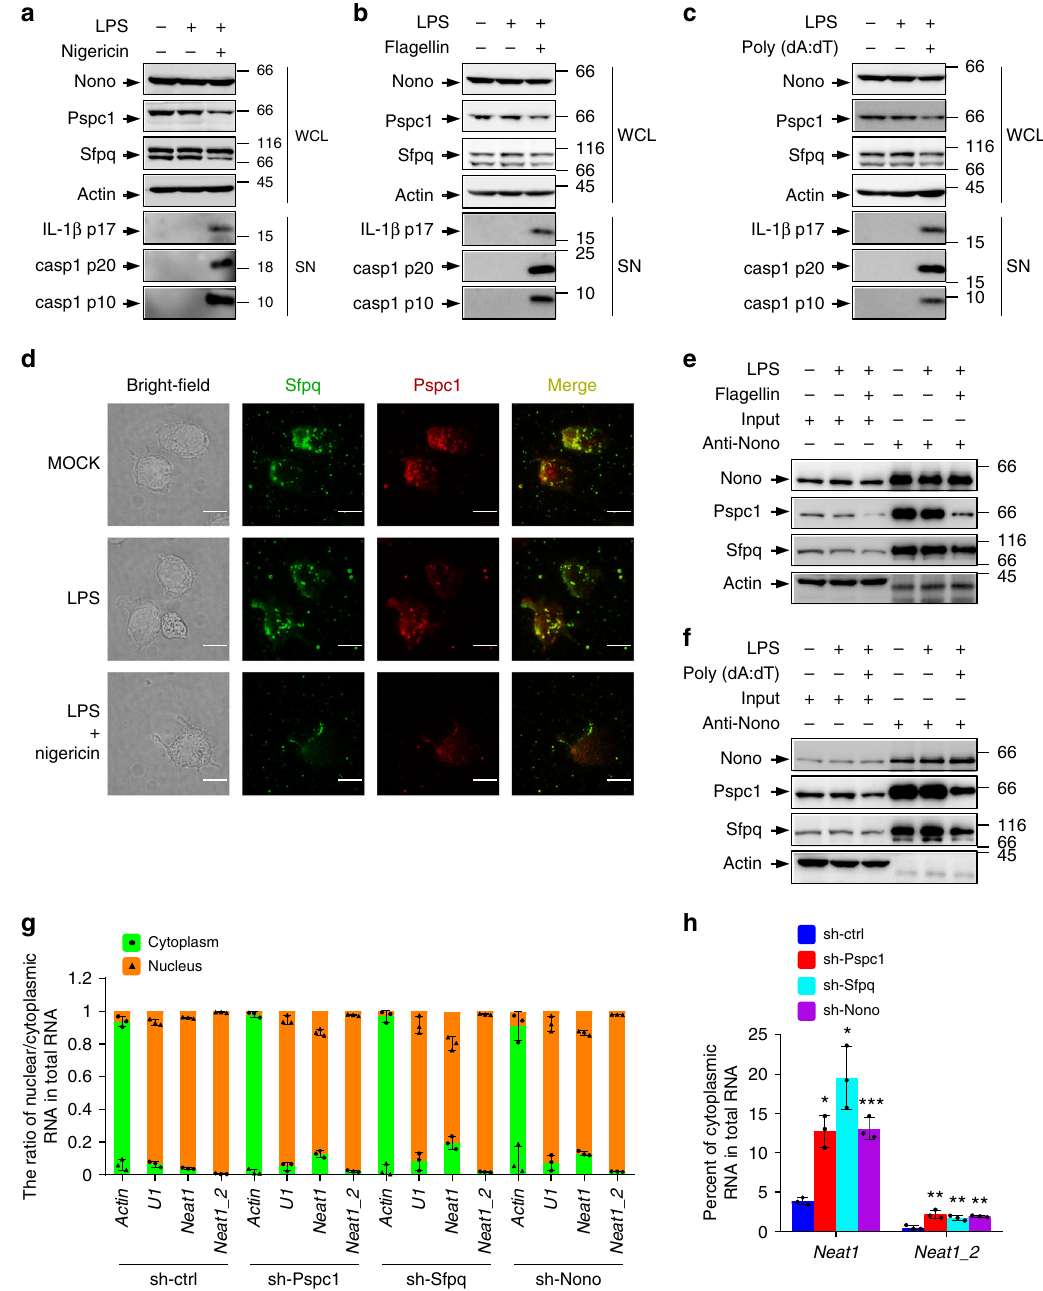
Fig. 8 Neat1 is released from nuclear paraspeckles into cytoplasm during in fl ammasome activation. a – c Cell lysates of untreated iBMDMs ( a – c ), LPS- primed iBMDMs ( a – c ), nigericin-activated iBMDMs ( a ), fl agellin-activated iBMDMs ( b ), or poly(dA:dT)-activated iBMDMs ( c ) were analyzed by Western blotting. d Colocation of paraspeckle proteins, Sfpq (green), and Pspc1 (red) were assayed by immunostaining. The location of paraspeckles (yellow) was obtained by merging two signals of Sfpq and Pspc1. The position of the nucleus is shown in the bright- fi eld image. e , f Interactions among paraspeckle components in untreated iBMDMs ( e , f ), LPS-primed iBMDMs ( e , f ), fl agellin-activated iBMDMs ( e ), or poly(dA:dT)-activated iBMDMs ( f ) were analyzed by co-immunoprecipitation assay. g , h iBMDMs infected with lentiviruses expressing control, Pspc1, Sfpq, or Nono shRNA were analyzed for the cytoplasmic and nuclear levels of Neat1 and Neat1_2 . Percentages of cytoplasmic Neat1 or Neat1_2 among total Neat1 or Neat1_2 RNA were shown in h . In d , the bar graph indicates 10 μ m. In g and h , data shown are mean ± SD ( n = 3). * P < 0.05, ** P < 0.01, *** P < 0.001, two-tailed t -test. Source data are provided as a Source Data fi